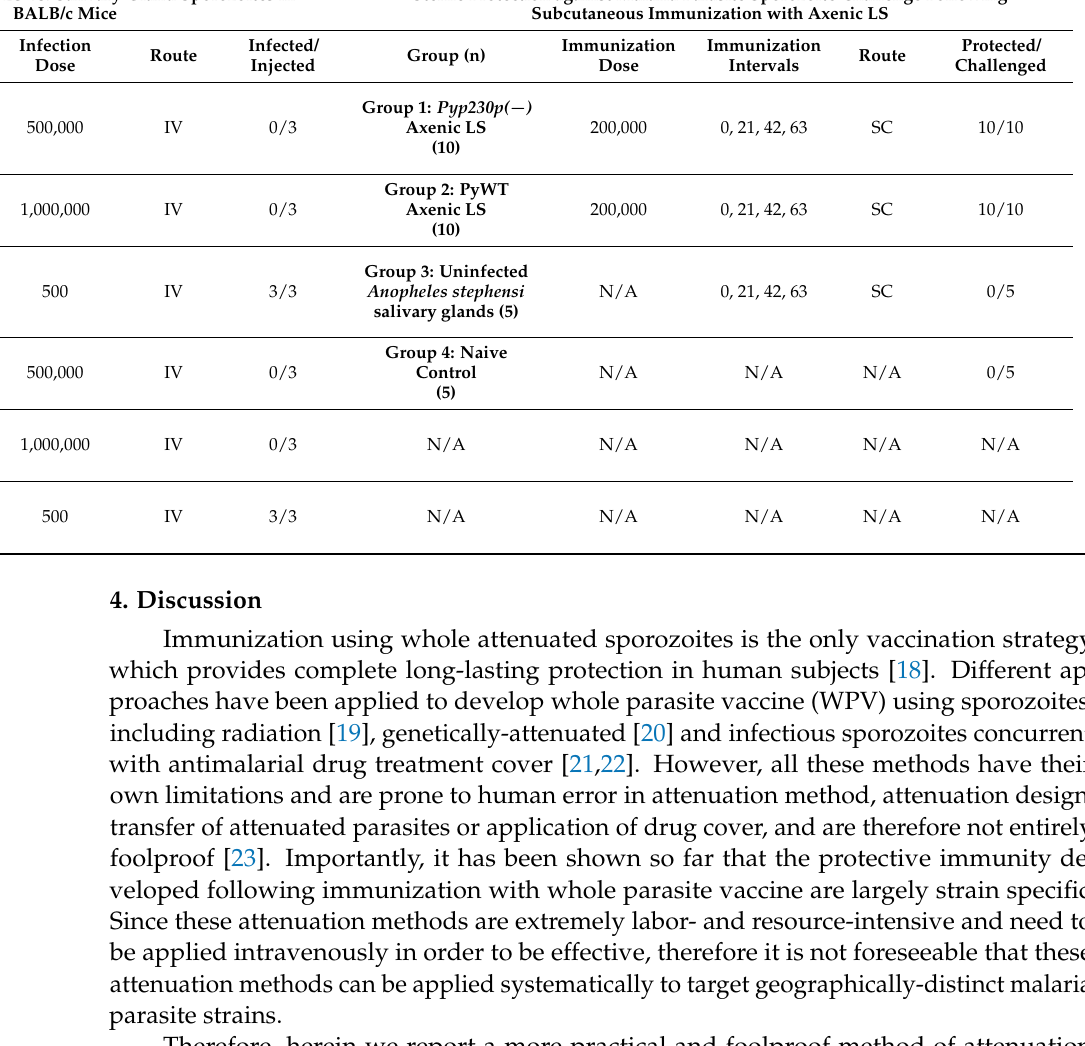
Table 1. Infectivity and Immunizations with axenically developed P. yoelii LS. Infectivity of Axenic LS vs. Salivary Gland Sporozoites in BALB/c